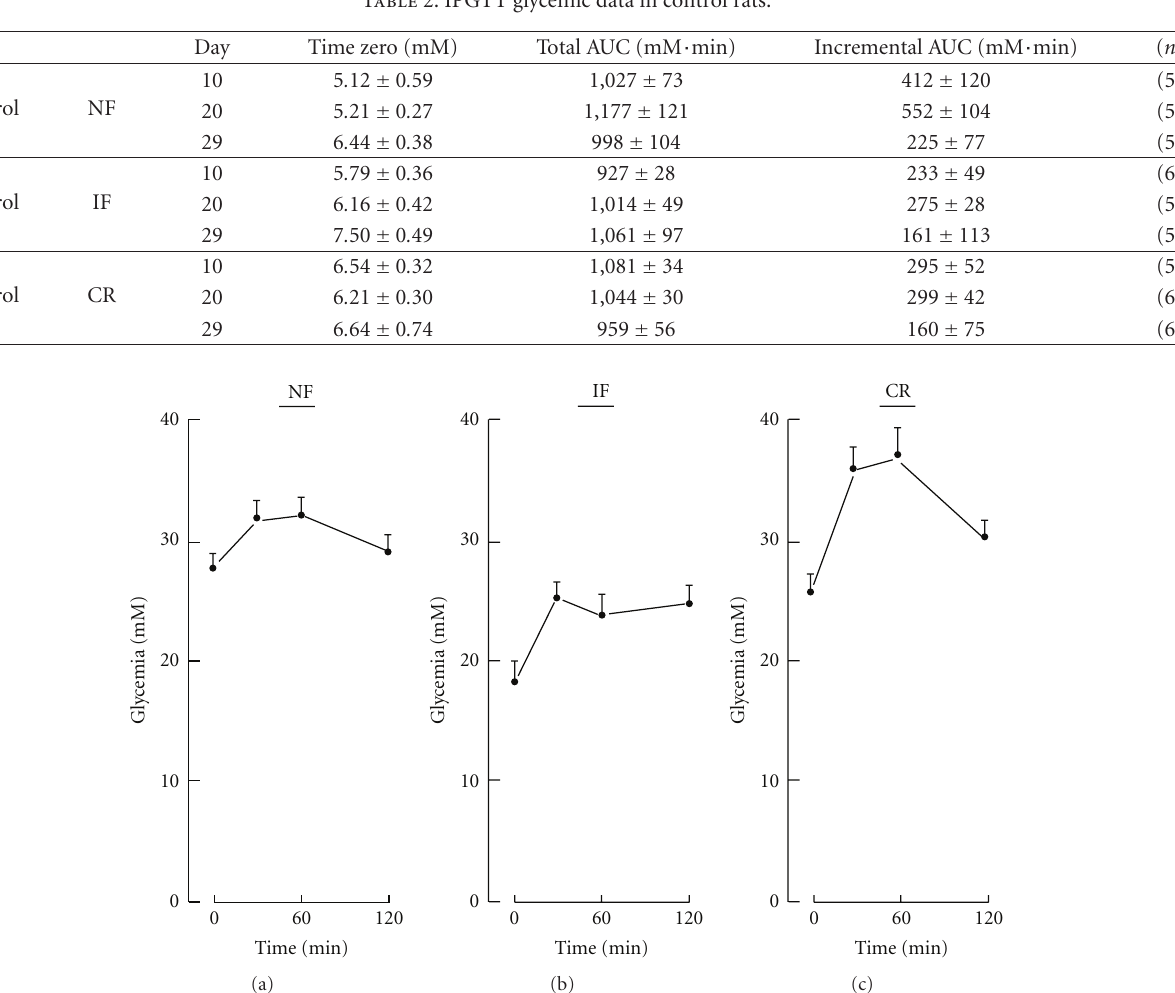
Figure 3: Glycemic profile during IPGTT conducted in NF (a), IF (b), and CR (c) STZ rats. Mean values ( ± SEM) refer to 15–20 individual experiments.